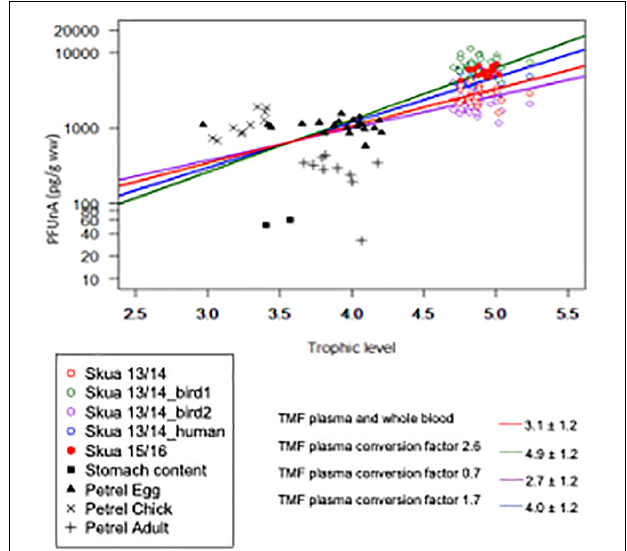
FIGURE 4 | Trophic magnification factors (TMFs) for PFUnA in the Svarthamaren food web leading to south polar skuas. The different regressions reflect the inclusion of the skua data with original data with skua whole blood from 2013 to 2014 (Skua_13/14—red, TMF = 3.1), converted skua plasma concentrations using the conversion factor 2.6 based on one ivory gull whole blood to plasma comparison in 2013 (Skua_13/14_bird 1—green TMF = 4.9), conversion factor 0.7 based on different ivory gulls from 2011 to 2014 (Skua_13/14_bird 2—purple, TMF = 2.7; Lucia et al., 2017) or conversion factor 1.7 based on human blood to plasma conversion (Skua_13/14_human—blue, TMF = 4.0; Poothong et al., 2017). All the regressions included measured skua plasmas from 2015 to 2016 (Skua_15/16, filled red